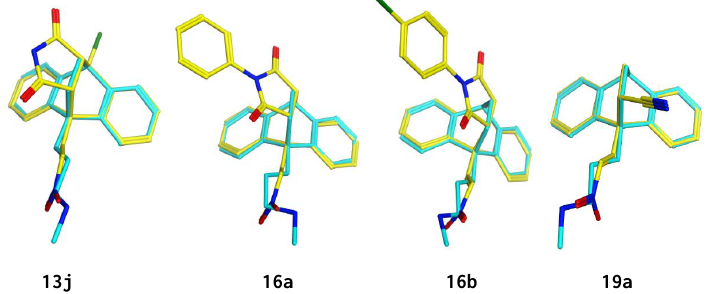
Figure 3. Overlay of 9,10-dihydroethanoanthracene compounds 13j , 16a , 16b and 19a (yellow) with maprotiline 8 (cyan). The atoms are coloured by element type: oxygen = red, nitrogen = blue, chlorine = green.